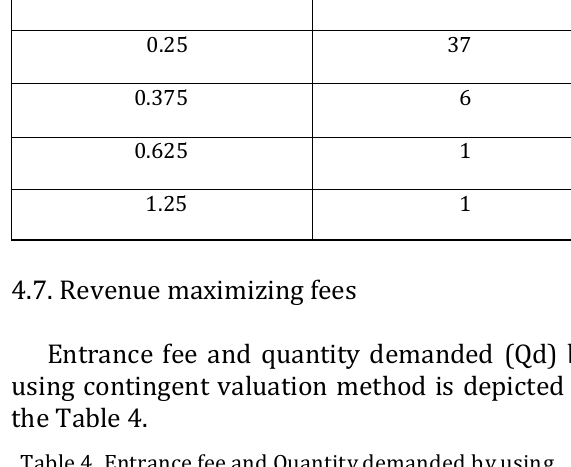
Table 4. Entrance fee and Quantity demanded by using